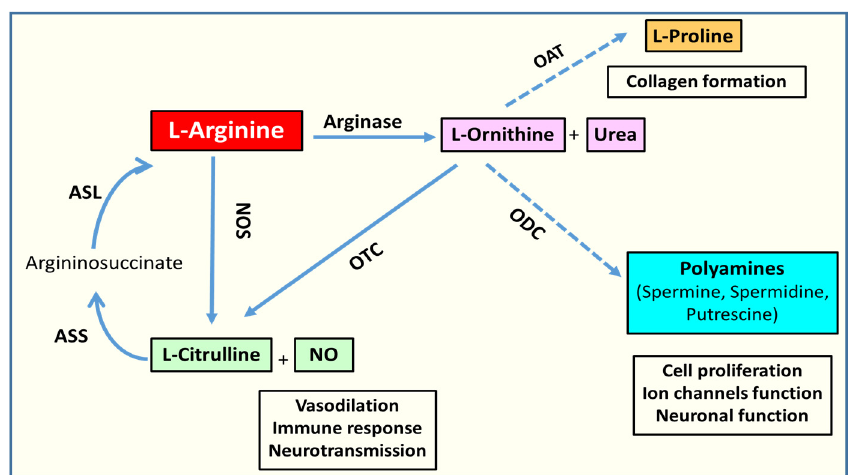
Figure 1. Schematic diagram of L-arginine metabolism. L-arginine is metabolized to L-ornithine and urea by arginase. It is also metabolized to L-citrulline and nitric oxide (NO) by the nitric oxide synthase (NOS). L-citrulline can be recycled back to L-arginine via the successive actions of argininosuccinate synthetase (ASS) and argininosuccinate lyase (ASL). L-ornithine can be converted to L-citrulline by the enzymatic action of ornithine transcarbamylase (OTC). L-ornithine can be used for polyamines production by ornithine decarboxylase (ODC). It can also be used for L-proline production by ornithine aminotransferase (OAT).